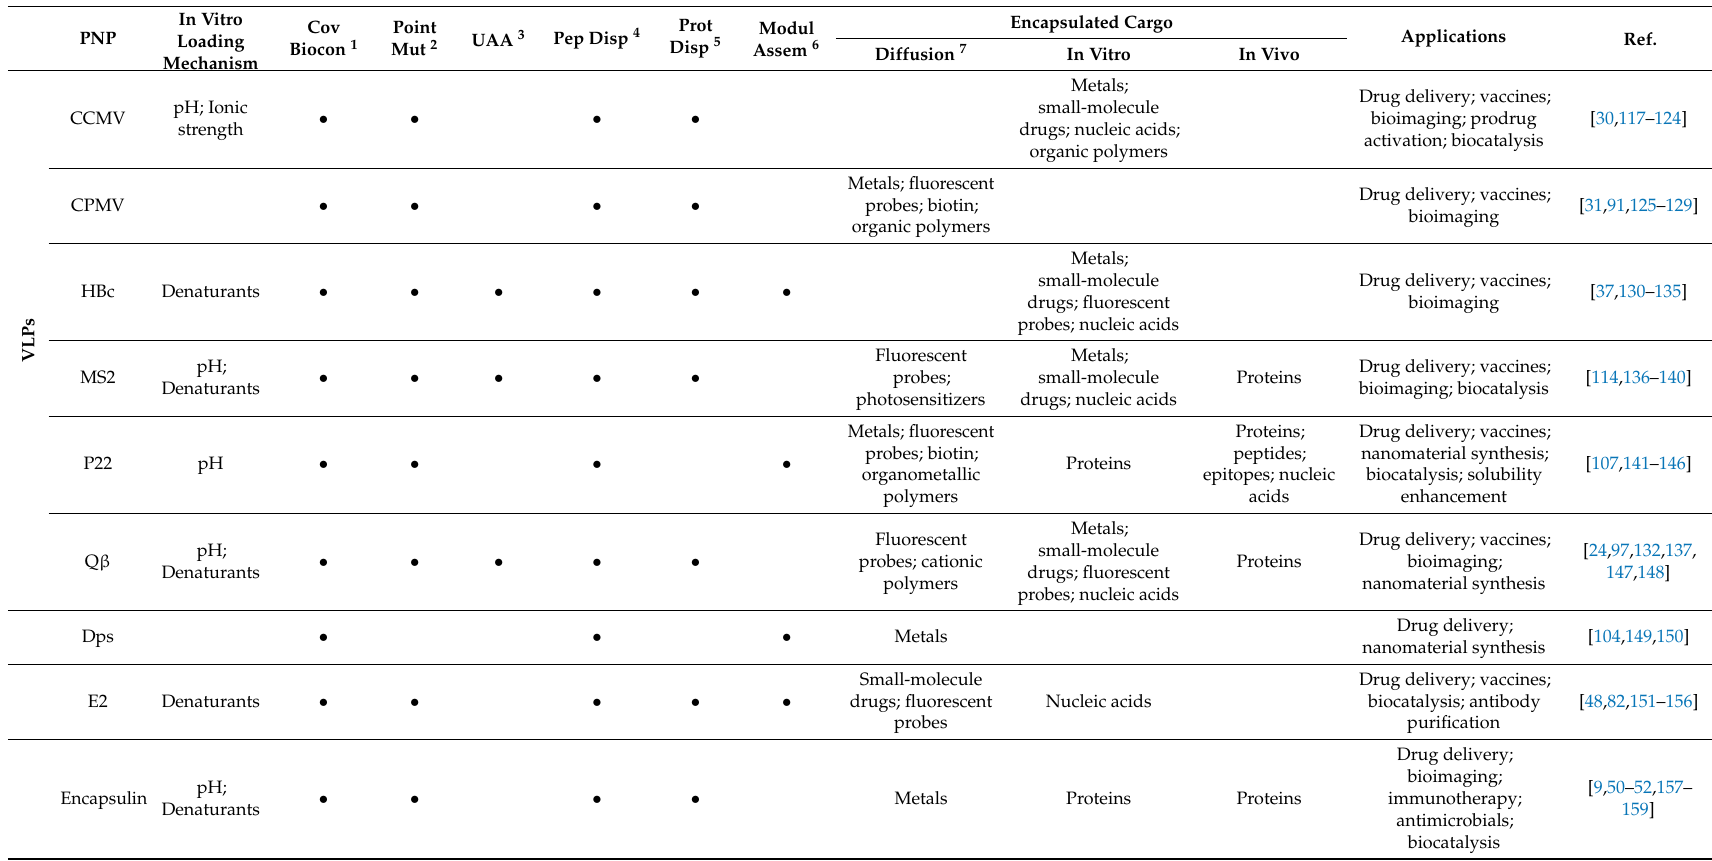
Table 2. Methods used to bioengineer the most commonly used PNPs for a range of